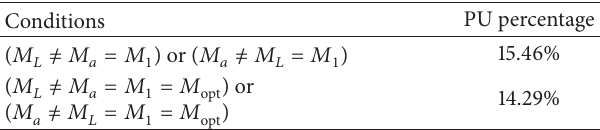
Table 1: Symbol definition for a current PU.